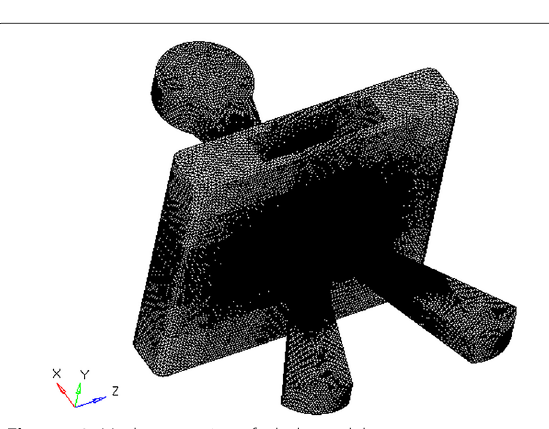
Figure 12 Mesh generation of whole model